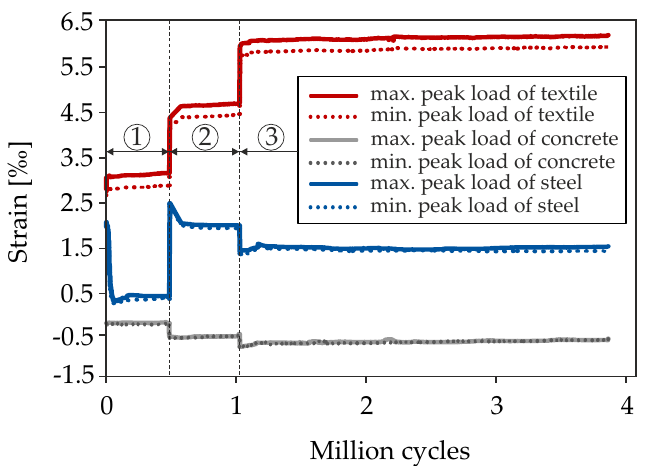
Figure 17. Development of the strains in the support axis during cyclic loading of test S8-2 referring to the peaks of the